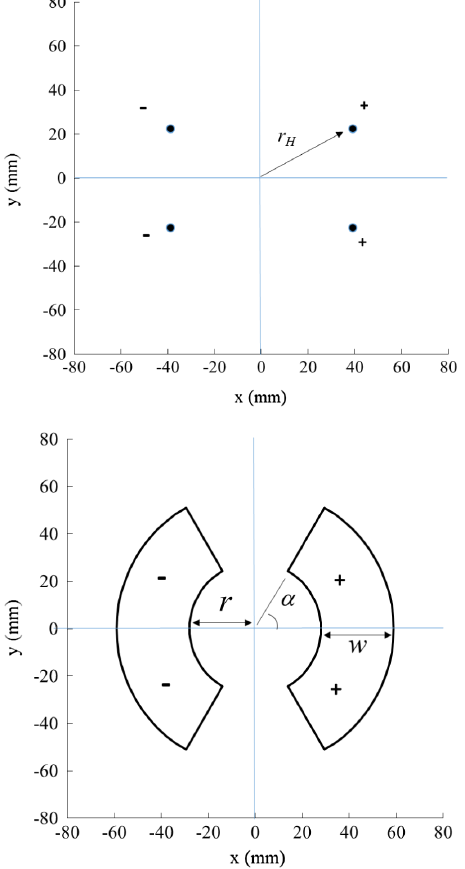
FIG. 2. A magnet given by a Helmholtz like coil (top) and a sector coil